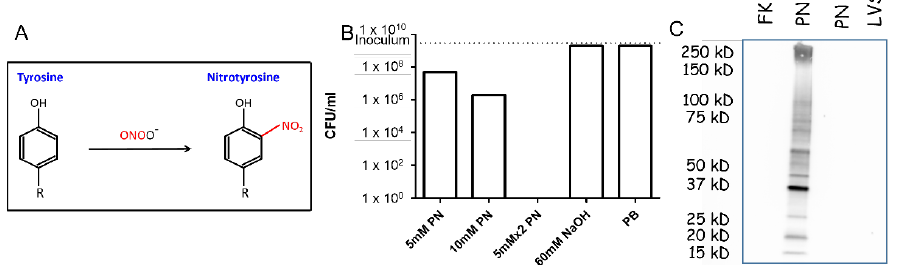
Figure 1. Peroxynitrite treatment of F. tularensis . ( A ) Modification of tyrosine residues by peroxynitrite (PN): the tyrosyl (phenol) group is nitrated, generating nitrotyrosine. ( B ) PN inactivation of F. tularensis : 5 × 10 9 CFU/mL F. tularensis was incubated with 5 mM or 10 mM PN for 15 min, or twice with 5 mM PN. As a control, bacteria were incubated with 60 mM of NaOH. The LOD for viable bacterial counts is 5 CFU/mL. ( C ) Western blot analysis of inactivated LVS cells. Lysates of inactivated LVS by formalin (formalin-killed, FK), peroxynitrite (PN), peroxynitrite-inactivated bacteria treated with dithionite (PN D), and untreated bacteria (LVS) were analyzed by a specific anti-NT antibody. Equal amounts (10 8 cell equivalents) of protein were loaded in each